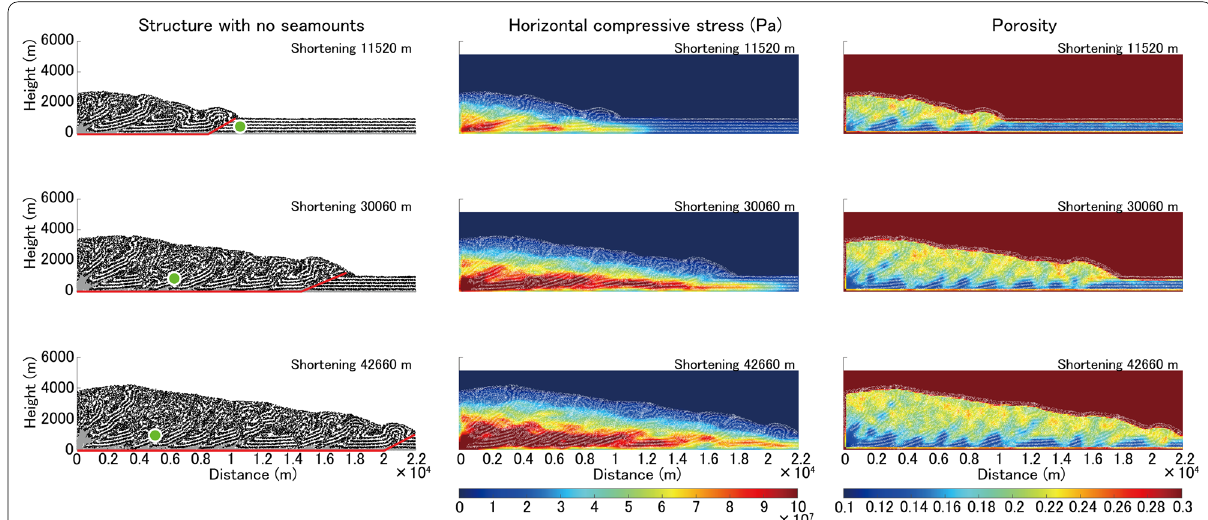
Fig. 2 Simulation results for the reference model without BTHs: geological structure (left), horizontal compressional stress (middle), and porosity (right). The geological structures are overlain on the horizontal stress and porosity as a translucent layer. Thick red lines in the left panels show the most active fault at that time. The green symbols on the geological structures (left) mark the locations of monitoring particles, which are monitoring points for the stress state and porosity (Fig.